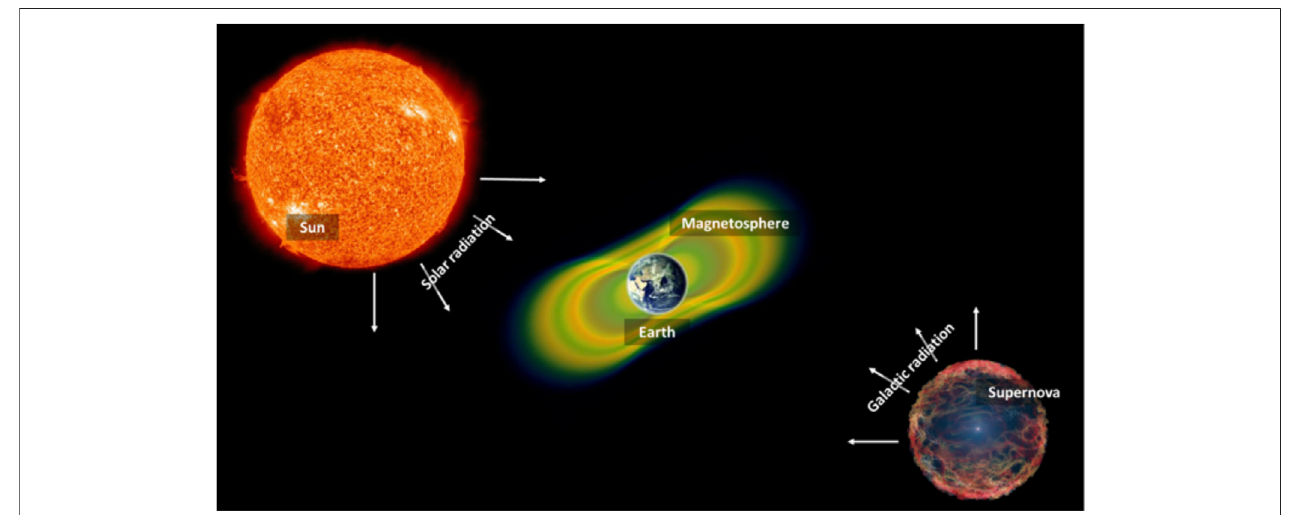
FIGURE 3 | Origins of space radiation. Radiation in space is derived from different sources, such as solar particle events, radiation trapped in our Earth ’ s magnetosphere as well as radiation coming from distant cosmic events (galactic radiation or galactic cosmic rays).